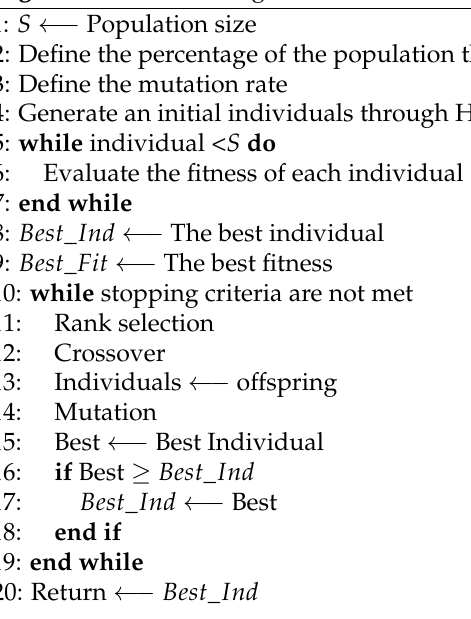
Algorithm 1 Genetic Algorithm